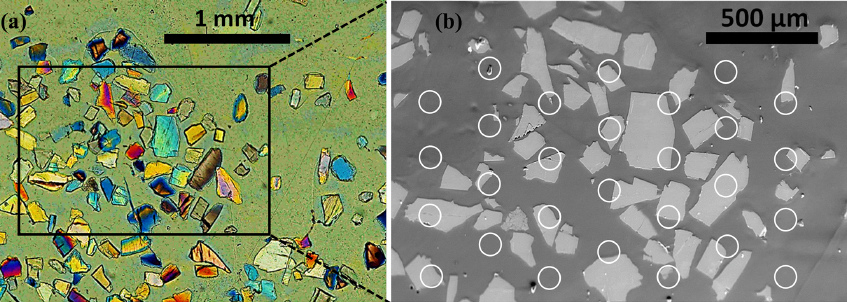
Figure 2. Grain mounts used in the droplet-freezing assay study. (a) Optical microscope image in transmitted light with crossed-polarizers and first-order retardation plate showing feldspar grains embedded in epoxy resin (sample FS08-01). (b) Backscattered electron (BSE) image of the area marked by the black frame in (a) . The white circles illustrate the footprints of water droplets used in the cold-stage